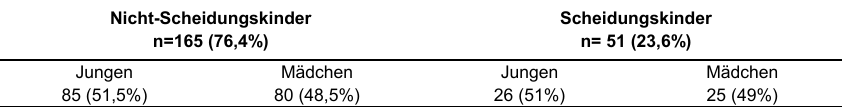
Scheidungskinder n= 51 (23,6%)